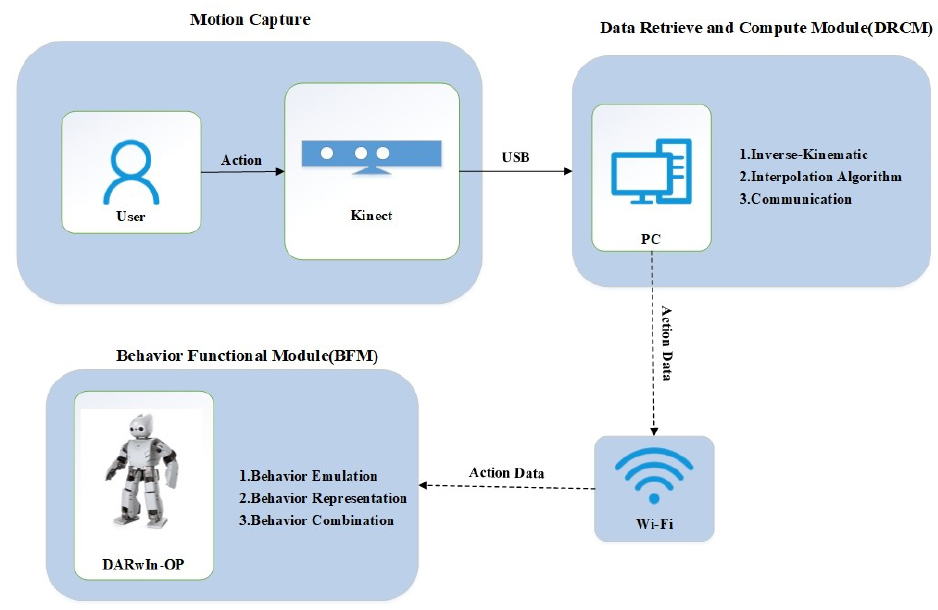
Figure 1. System architecture.